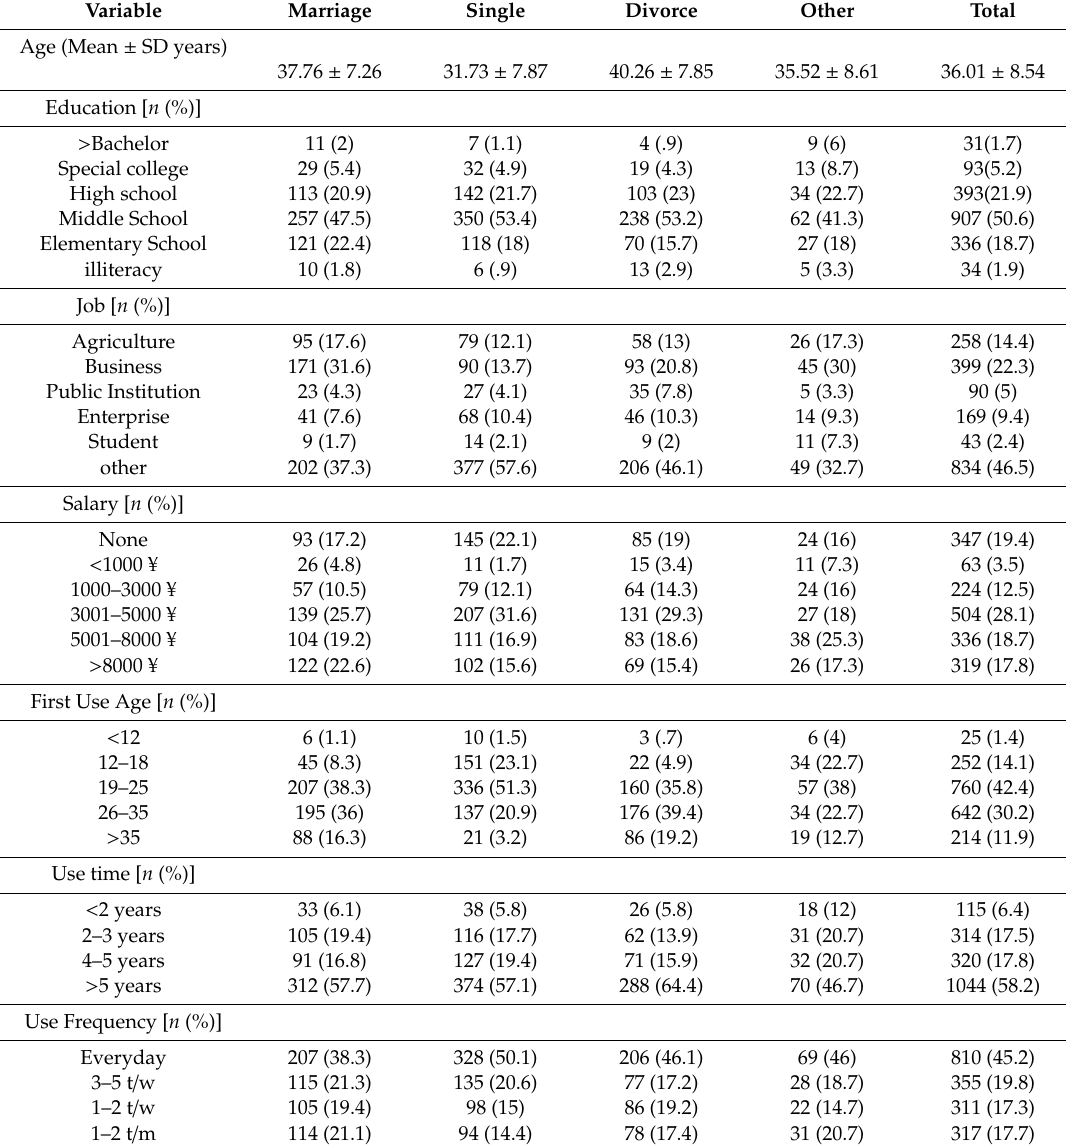
Table 1. Descriptive statistics for each outcome by marital